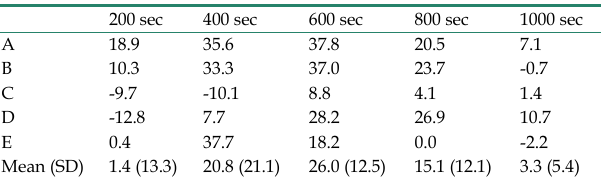
Table 2. Relative colony reduction per test